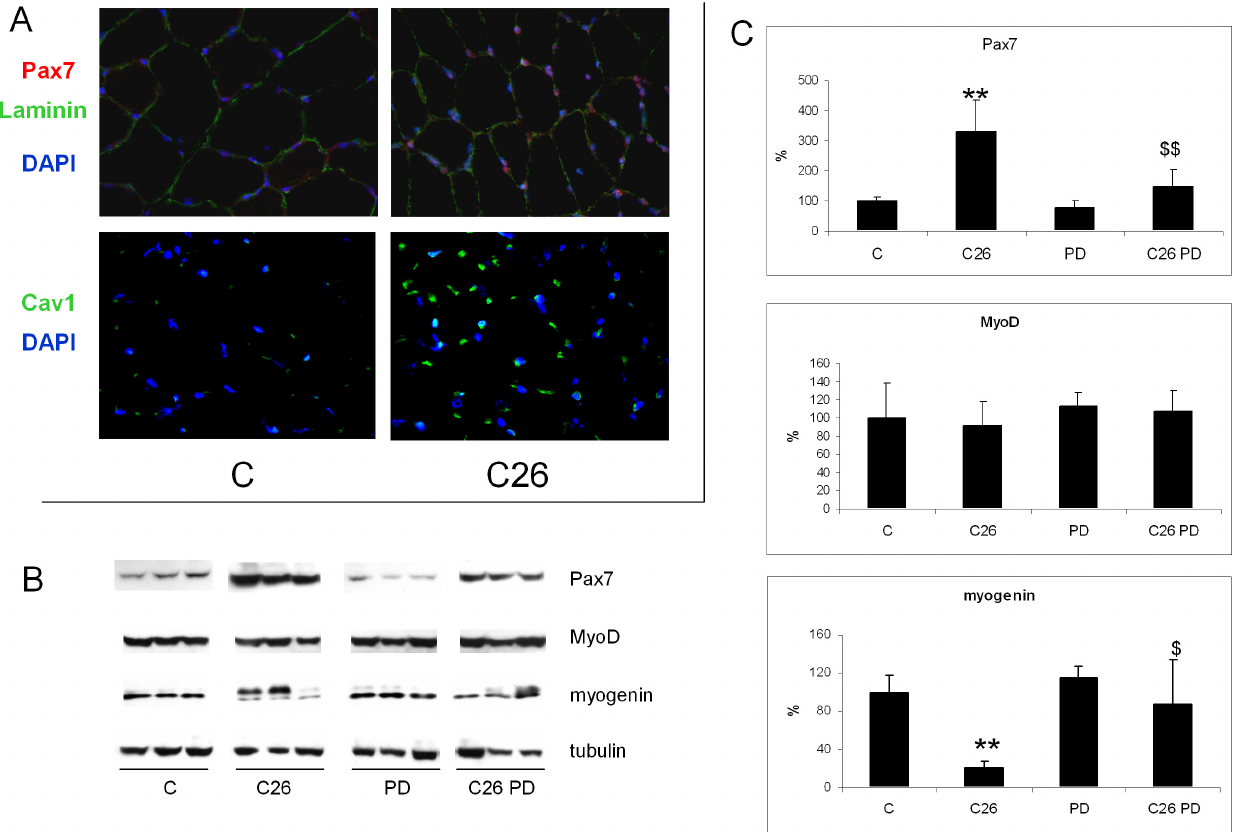
Figure 5. ERK inhibition restores the myogenic potential in TB mice. (A) Immunostaining of Pax7, laminin and caveolin1 (Cav1) in tibialis transverse sections of controls and TB mice. (B) Pax7, MyoD and myogenin protein expression in the GSN of controls (n=6) and TB mice (n=8) either untreated or administered PD (1 mg/kg) and (C) corresponding densitometric analysis normalized by tubulin. Data (means 6 SD) are expressed as percentages of controls. Significance of the differences: **p , 0.01 vs C; $ p , 0.05 vs C26; $$ p , 0.01 vs C26.